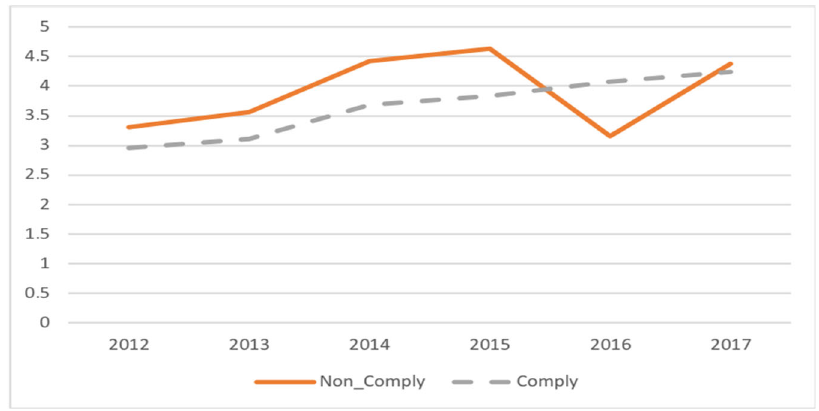
Figure 3. Average ROA (%) trends Note: Non_comply is mean of companies which appointed two or more independent directors after June 2015 and Comply is mean companies which appointed two or more independent directors before June